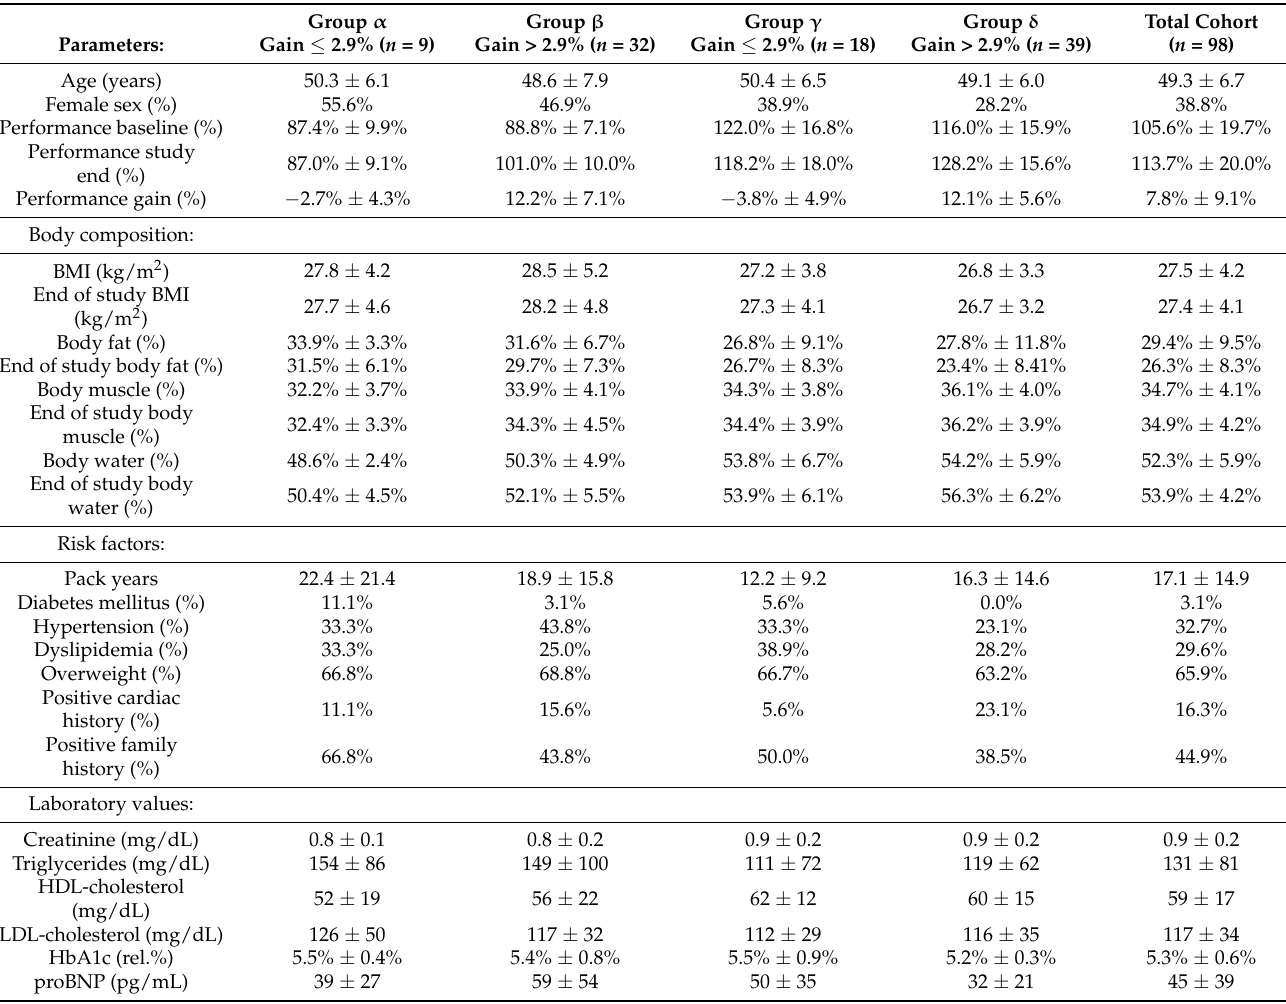
Table 1. Baseline characteristics of the total cohort as well as the subgroups α , β , γ , and δ . BMI = body mass index, HDL = high-density lipoprotein, LDL = low-density lipoprotein. Data are presented as median and interquartile ranges (25th–75th quartile) or percentages. Group α Group β Group γ Group δ Total Cohort